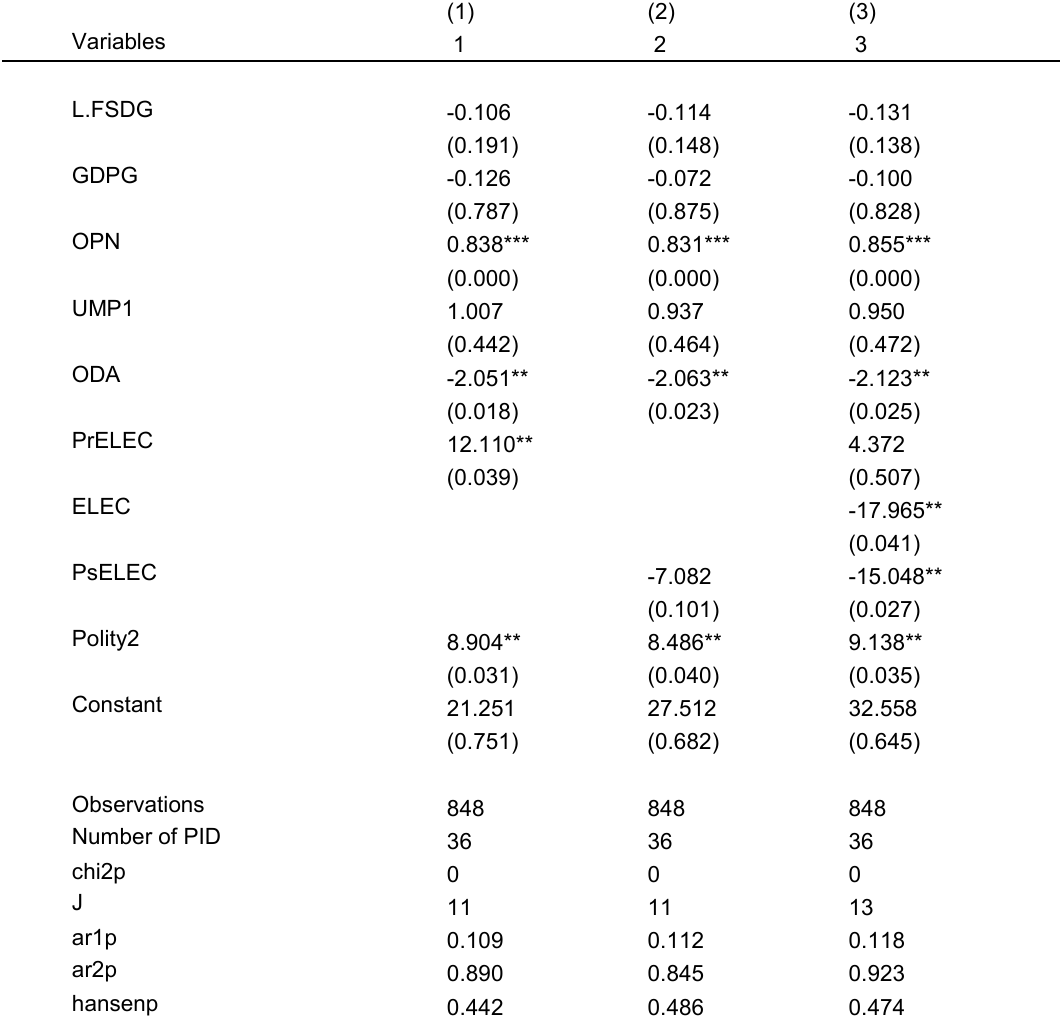
Table 4. Estimated System GMM Dynamic Panel Regression Results With Pre and Post-Election